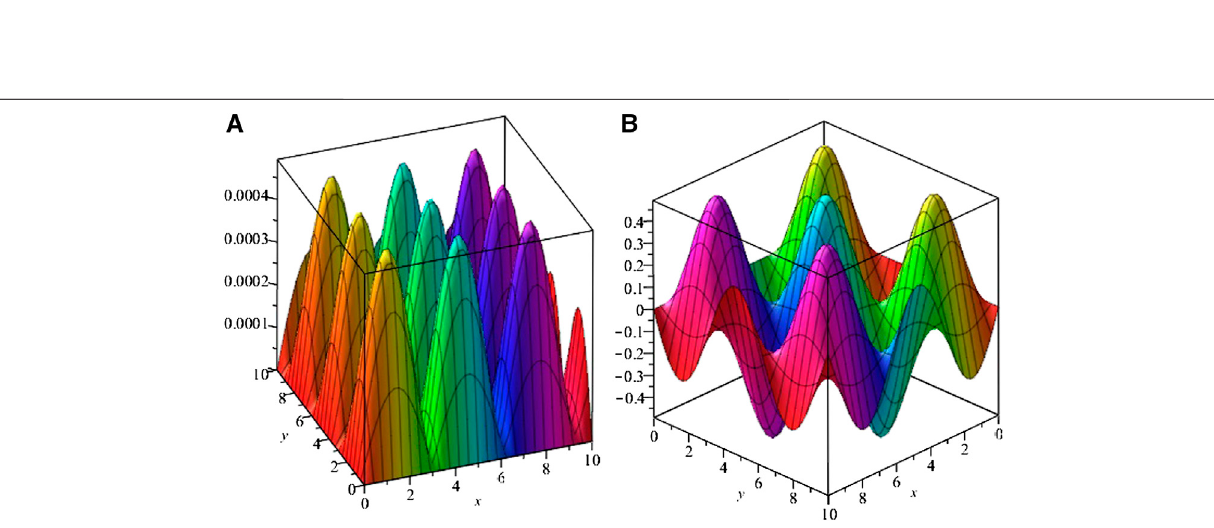
FIGURE 7 | (C) Error graph (D) ISTM solutions of example 4 at α (cid:2) 0 , 5. In Figure 7 , the sub-graphs (C) and (D) represent the ISTM Error and solution graphs of Example 4 respectively. The error graph has con fi rmed the higher accuracy of ISTM.